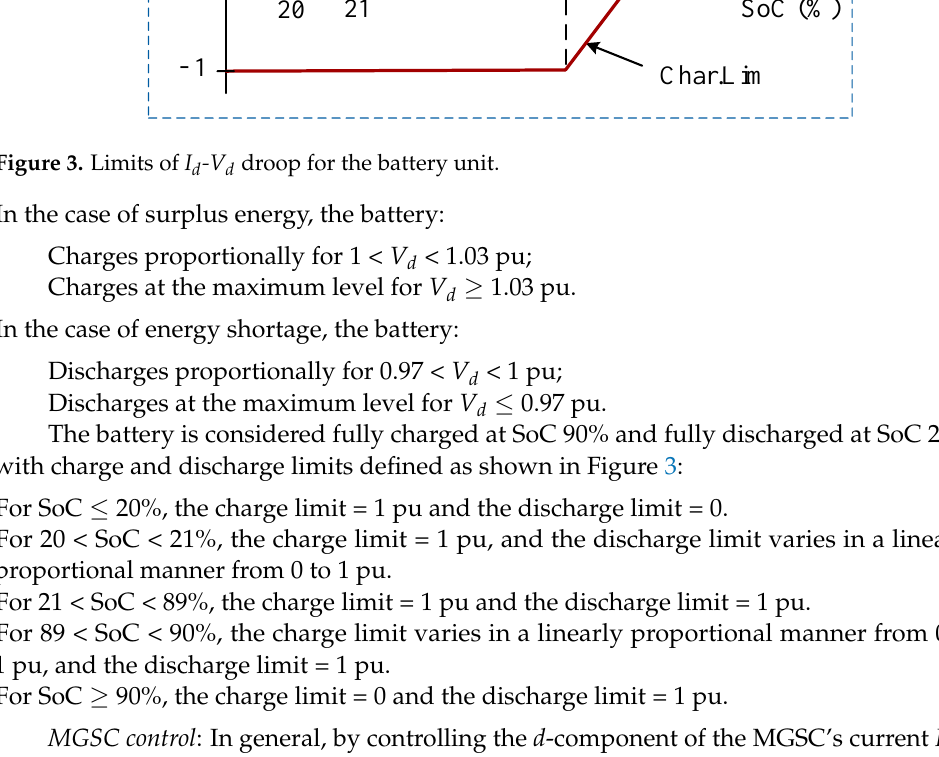
Figure 4. I d -V d droop control for the modular configuration of the grid-interfacing converters ( a ) for MGSC-1, ( b ) for MGSC-2 and ( c ) for MGSC-3 (see Figure 1). Setting the MGSCs’ I d - V d droop in this way enables them to conduct in sequence: i.e., only MGSC-1 conducts if the lack/excess of MG power is up to 2 MVA, while MGSCs-2 and -3 start contributing when this power exceeds 2 and 4 MVA, respectively. This approach minimizes converter s’ loss in the proposed modular configuration. Note that the dead- zone margins can be changed or even removed according to the converters’ sizes and the desired operational